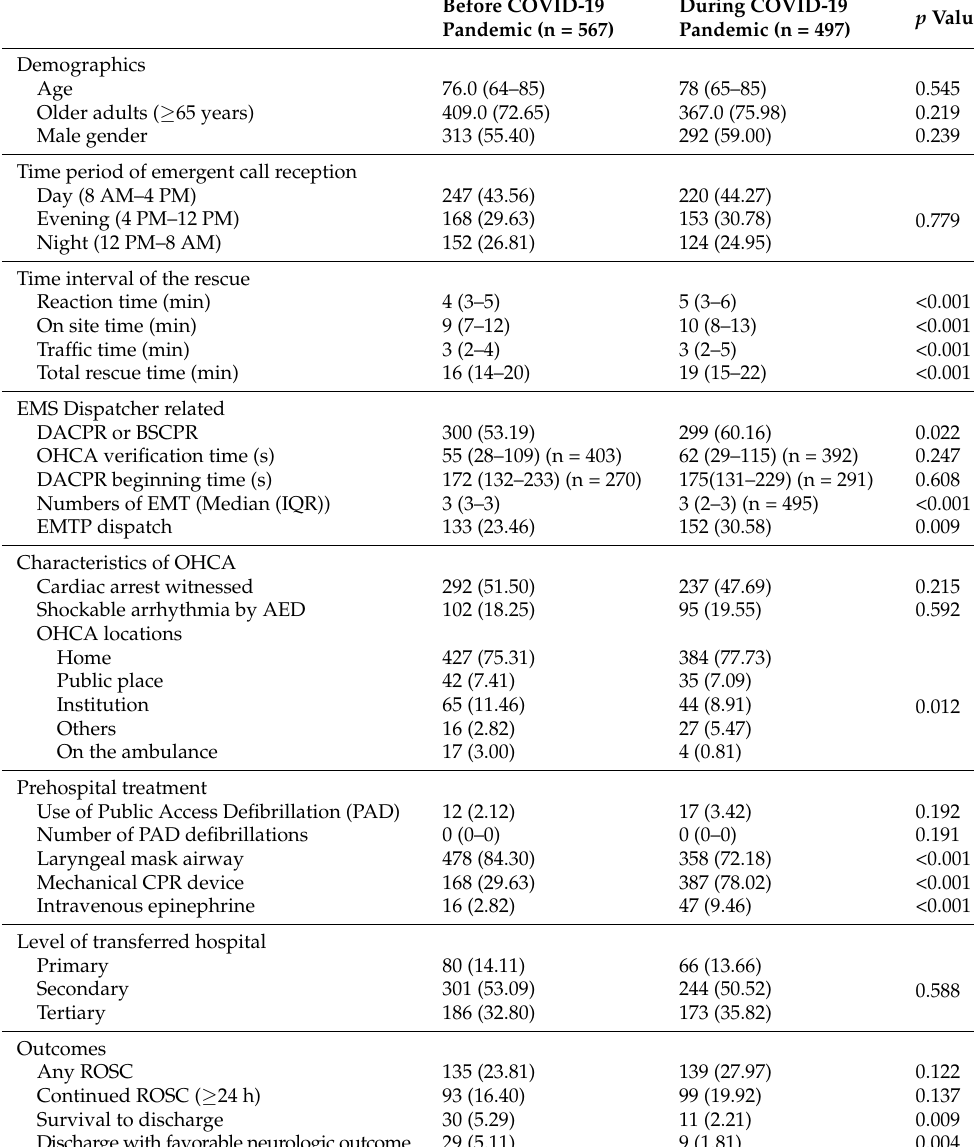
Table 1. Specific features of OHCA patients before and during COVID-19